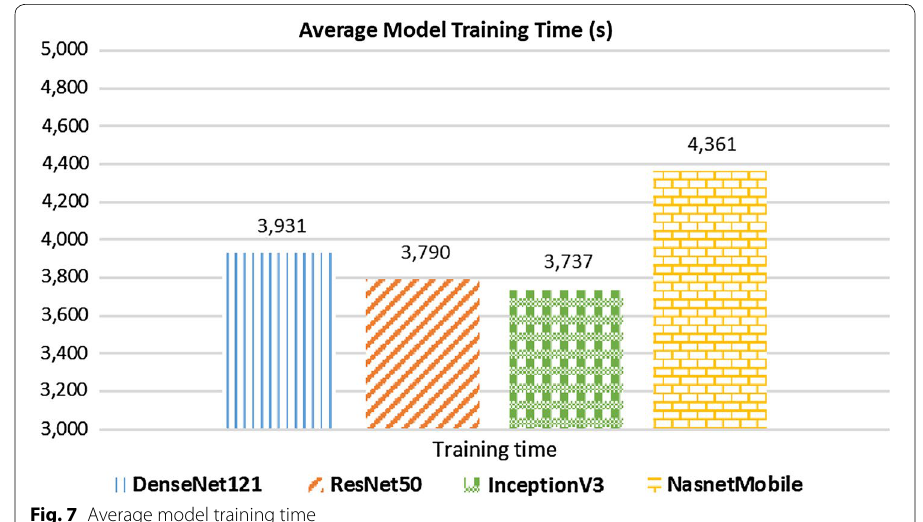
Fig. 7 Average model training